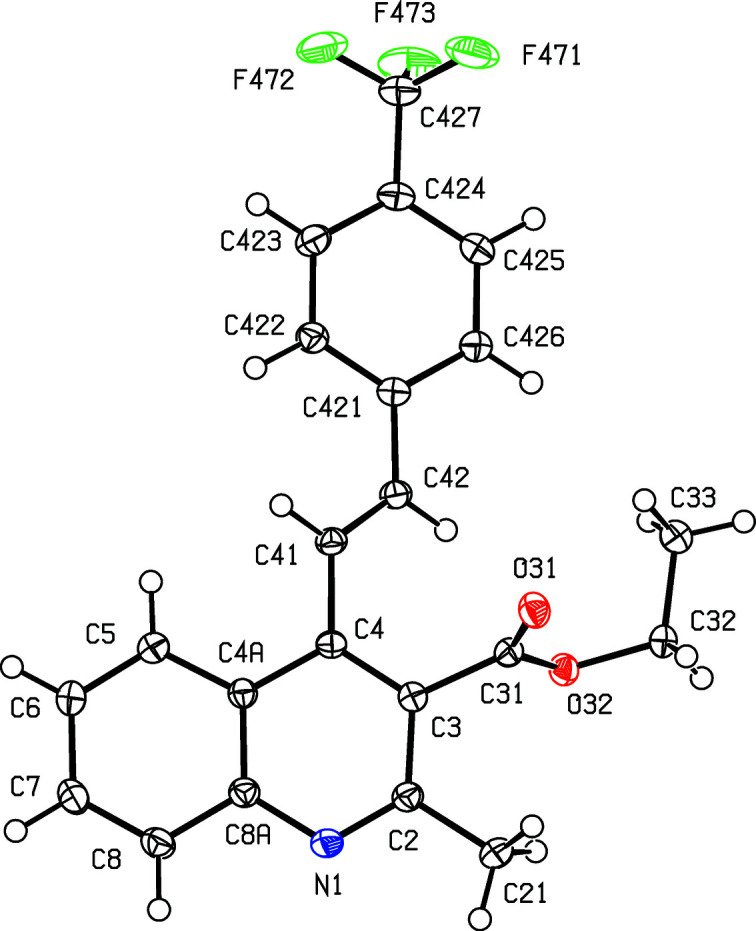
The mol­ecular structure of com­pound (VI), showing the atom-labelling scheme. Displacement ellipsoids are drawn at the 50% probability level.